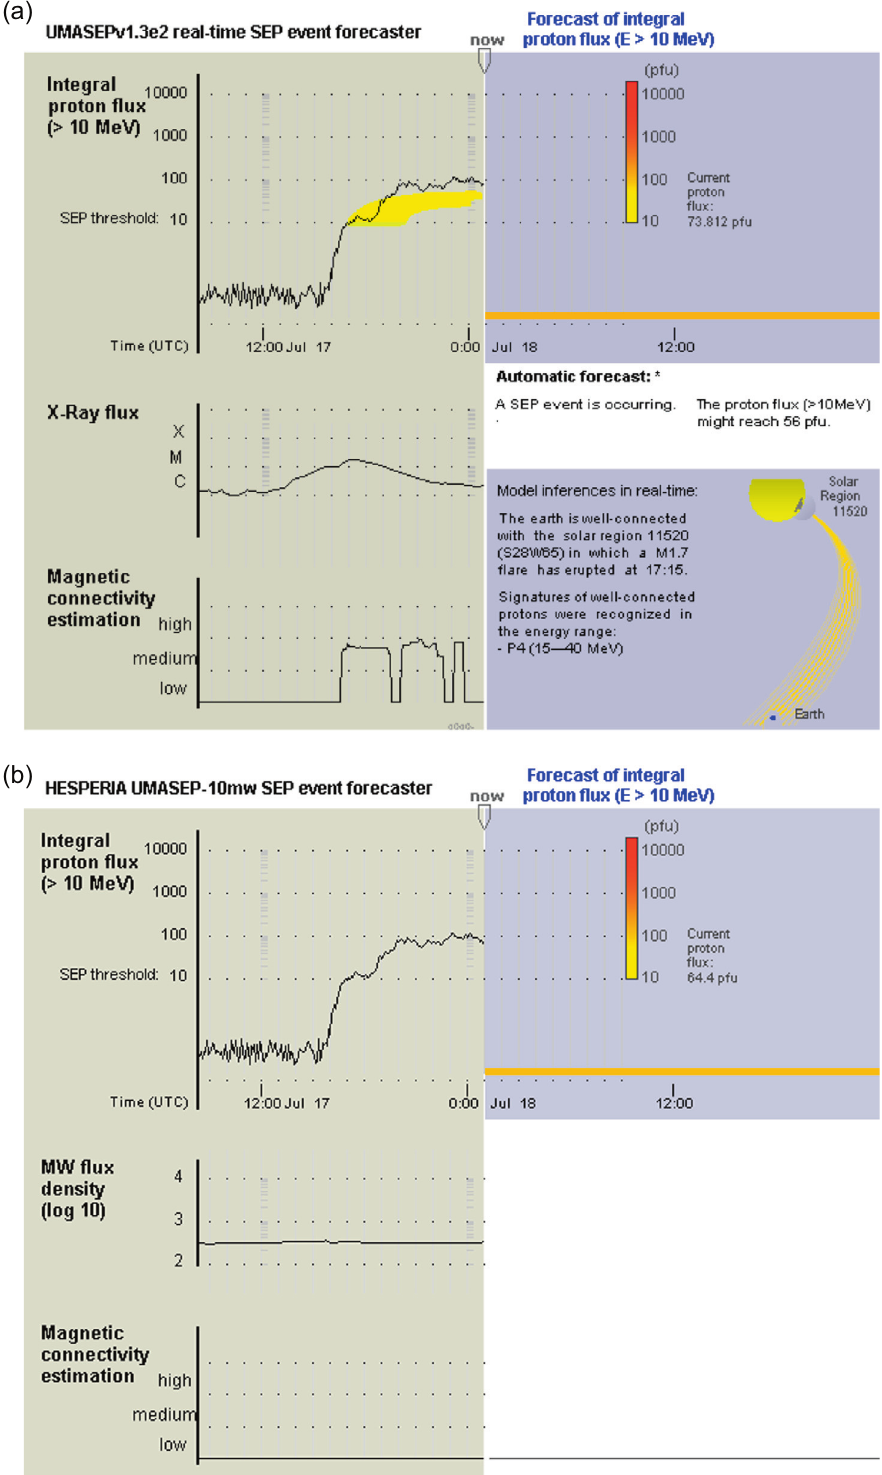
Fig. 7. UMASEP prediction web page for 2012 July 17: (a) and (b) show the SEP prediction using soft X-rays and microwaves,